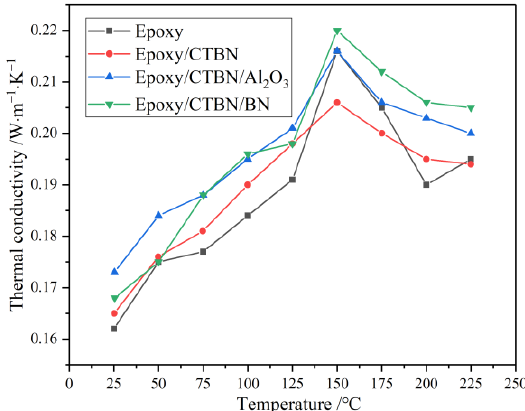
Figure 3. Temperature dependence of thermal conductivity of four kinds of samples.